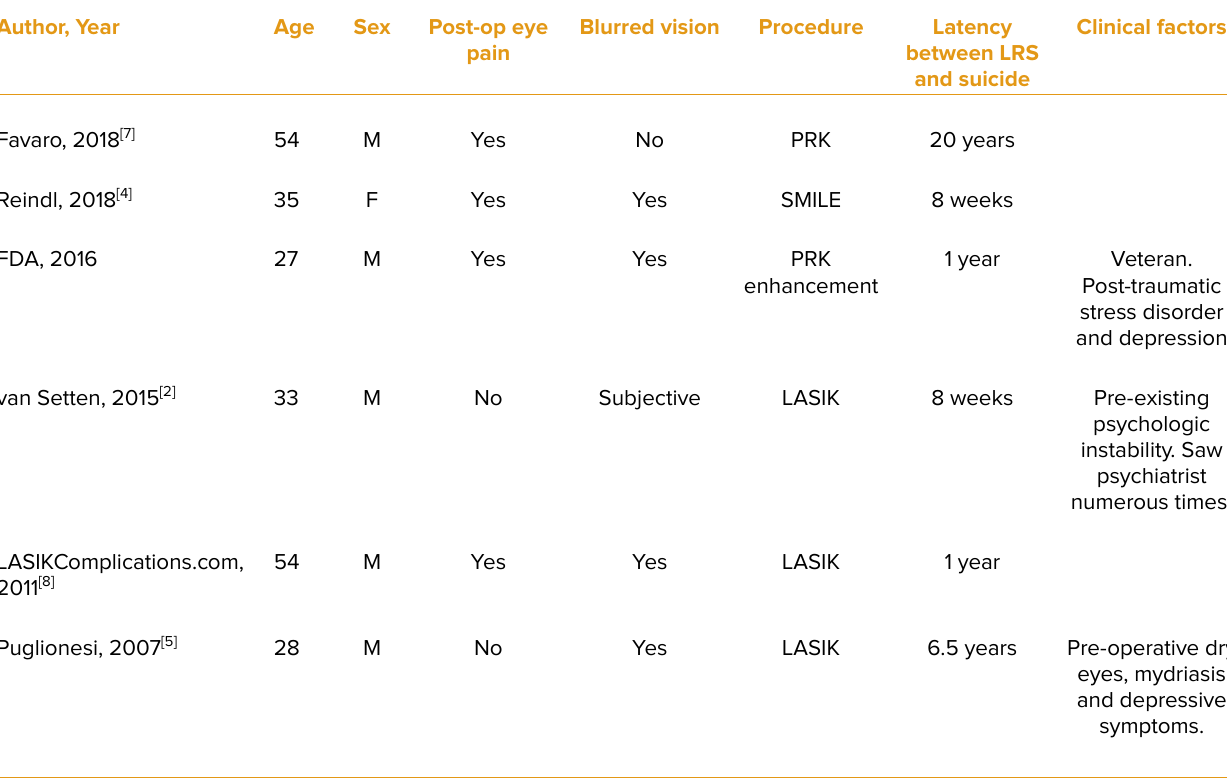
Table 1. Patients with completed suicide after LRS Author,